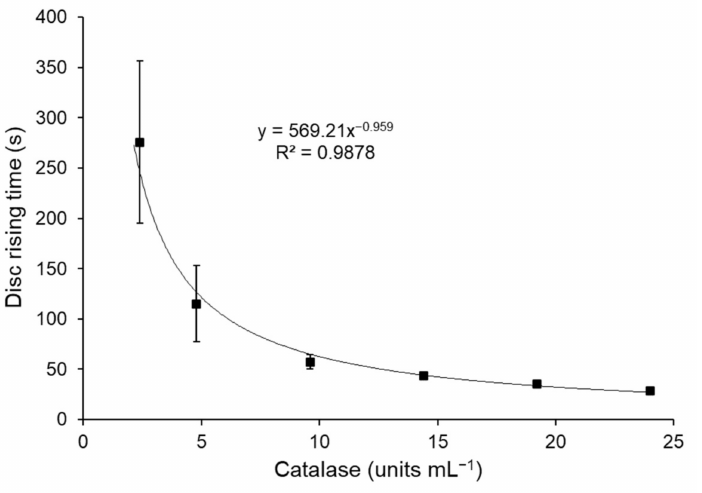
Figure 2. Calibration curve for disc rising time versus catalase units per